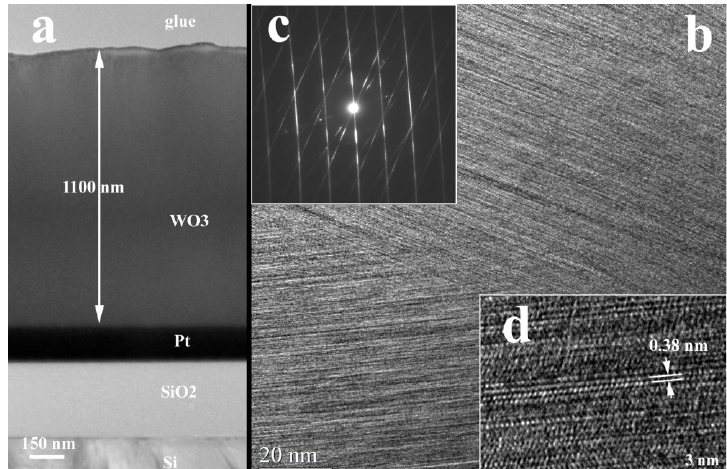
Figure 3. XTEM images of the WO 3 film deposited on Pt/SiO 2 /Si substrate using the 355 nm laser radiation; ( a )—Low magnification TEM image of the sample cross ‐ section; ( b )—columnar grain structure of the film; ( c )—SAED of the columnar grain structure; ( d )—HRTEM detail of the WO 3 columnar grain structure, showing the 2D crystalline